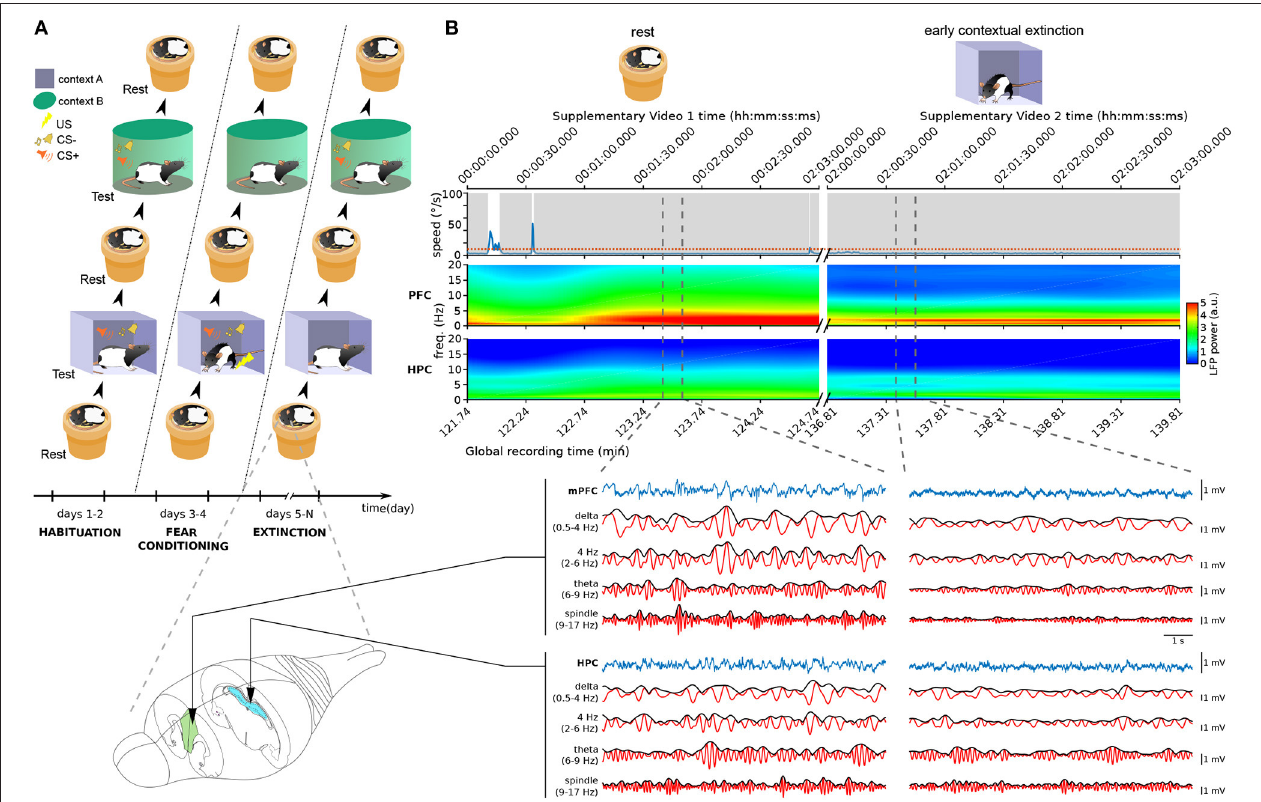
FIGURE 1 | Neural and behavioral activity during rest vs. freezing (A) Overview of the behavioral protocol. Each day, animals were exposed to a resting environment (a familiar non-anxiogenic flowerpot) and to two testing environments (A,B) . In habituation sessions (2 days, left), animals were exposed to context A and context B and to the auditory stimuli employed in the protocol. This was followed by fear conditioning (2 days, middle) where the presentations of the conditioned stimulus (CS+) in context A were coupled with the delivery of aversive footshocks. In the following days of the protocol (6–12 days, right), the animals underwent contextual fear extinction in context A as well as cued fear extinction in context B (see Section 4). (B) Example neural activity recorded during sleep in the resting environment (left, see Supplementary Video 1 ) and during freezing in context A (right, Supplementary Video 2 ) in the first day of extinction training. Time stamps corresponding to those overlaid in Supplementary Video frames are shown on top. (Top) Animal speed as measured by head movements; red dotted line: threshold used to detect immobility; gray shadings: immobility periods. (Middle) Spectrograms of the LFP recorded in the medial prefrontal cortex (mPFC) and hippocampus (HPC). Vertical dashed lines: The boundaries of example intervals represented on the bottom. (Bottom) mPFC and HPC LFP signal recorded in the intervals marked above. Blue: raw recorded LFP; red: filtered LFP in the delta, 4Hz, theta, and spindle frequency bands; black: instantaneous amplitude of the filtered